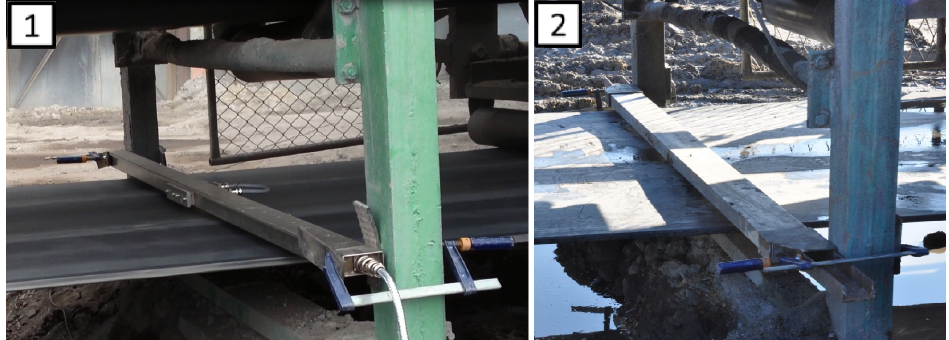
Figure 2. Magnetic head ( 1 ) and magnetic bar ( 2 ) installed on the belt conveyor.